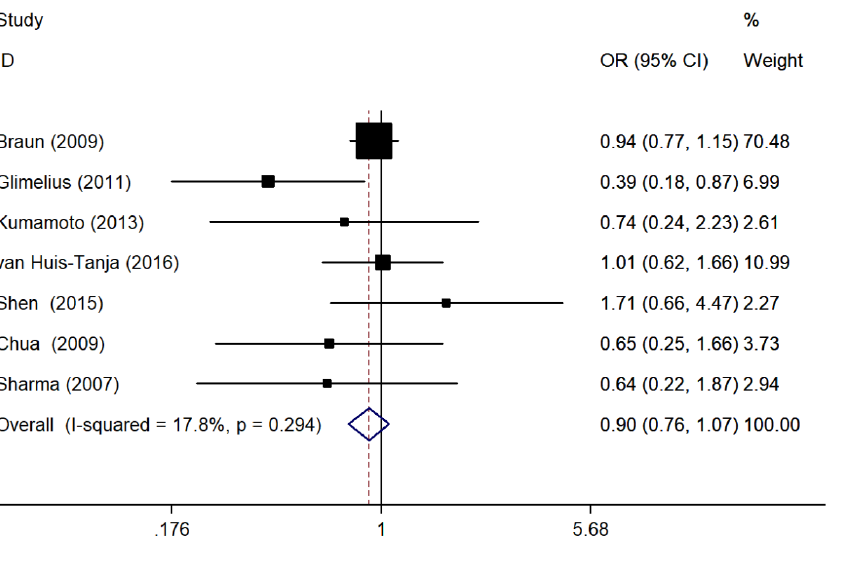
Figure 4: Forest plot of MTHFR gene rs1801133 C>T polymorphisms and grade 3-4 adverse reaction of colorectal cancer in recessive genetic model [dominant genetic model (CT+TT) vs